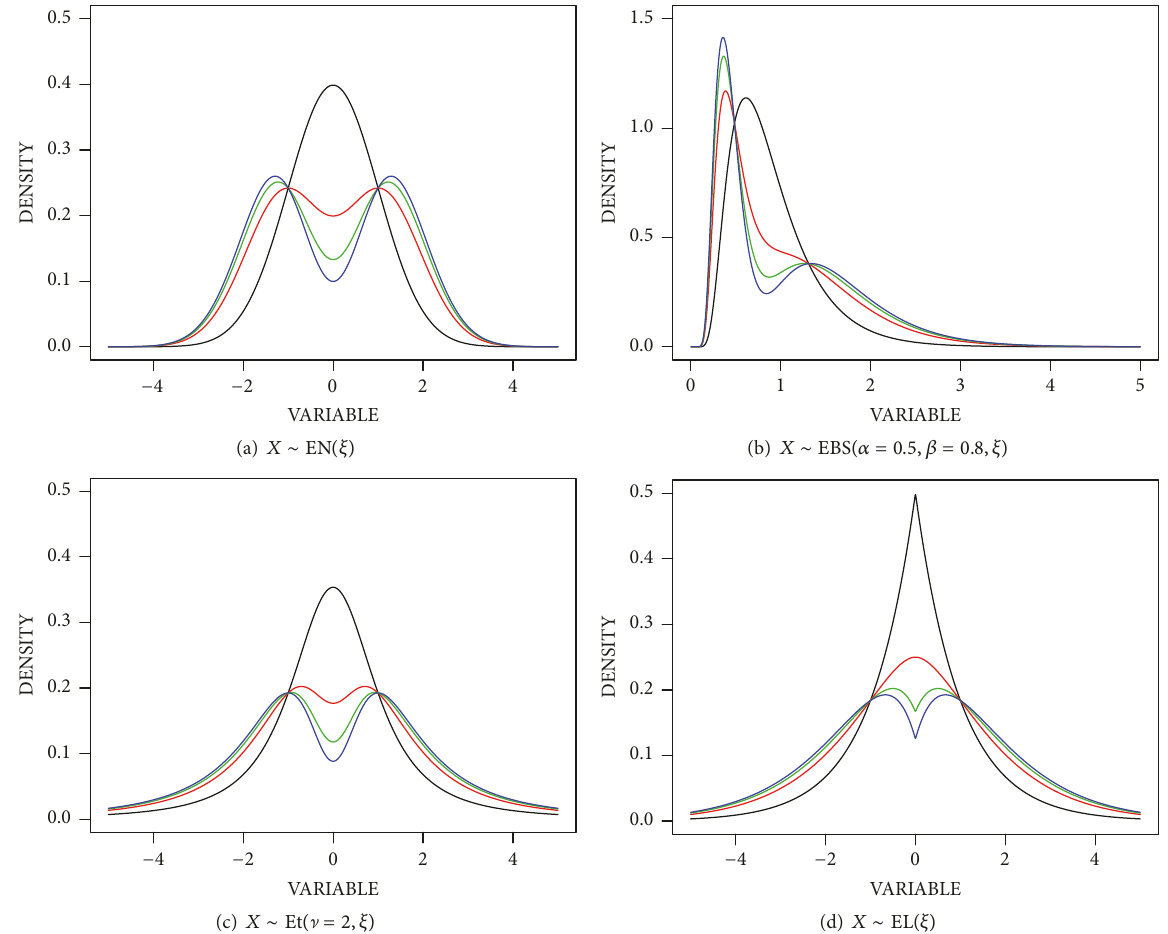
Figure 1: PDF’s for the special cases defined in Corollaries 5–8 and several values of 𝜉 . 𝜉 = 0 (black line), 𝜉 = 1 (red line), 𝜉 = 2 (green line), and 𝜉 = 3 (blue